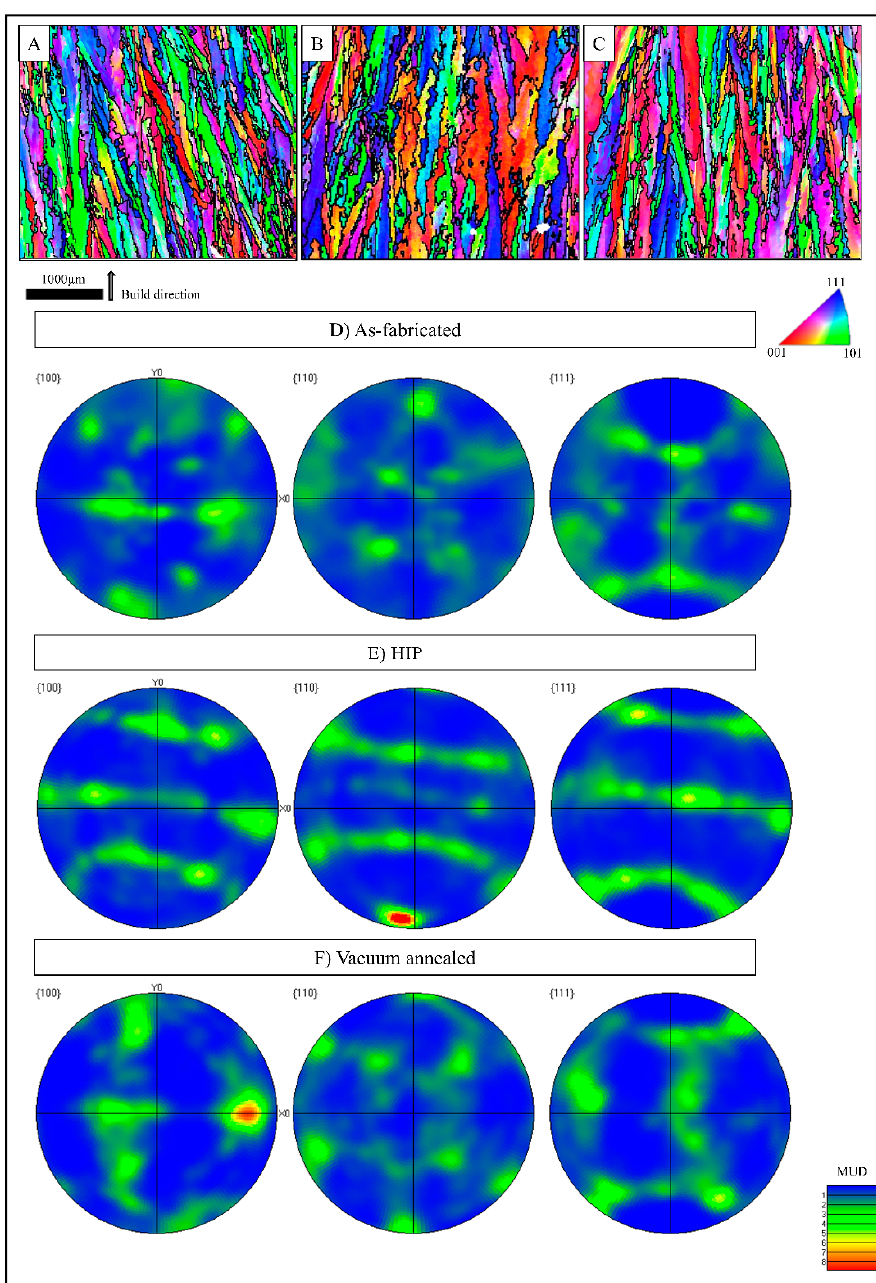
Figure 7. Inverse pole figure maps of as-fabricated, HIP, and vacuum-annealed specimens along the build direction shown with an arrow alongside the scale bar ( A – C ); pole figures of as-fabricated, HIP, and vacuum-annealed specimens ( D – F ), respectively. The color bar is multiple uniform density (MUD) for the pole figures ranging from 1–9.